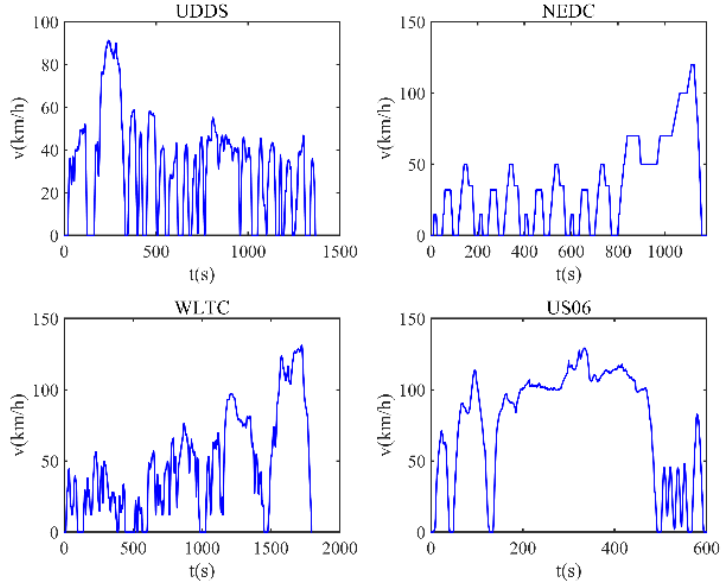
Figure 6. The speed curves of four driving cycles.